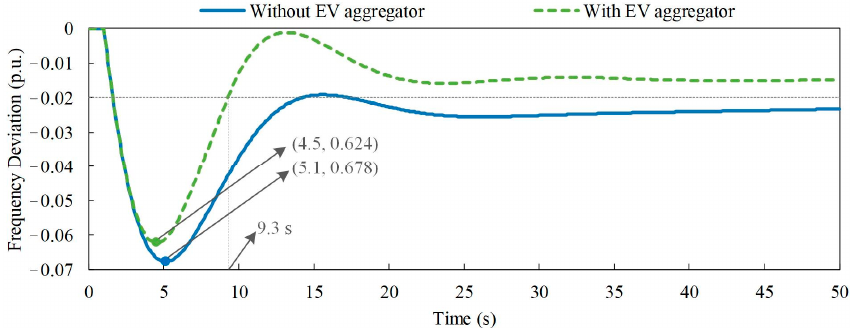
Figure 7. System frequency regulation without and with the EV aggregator.